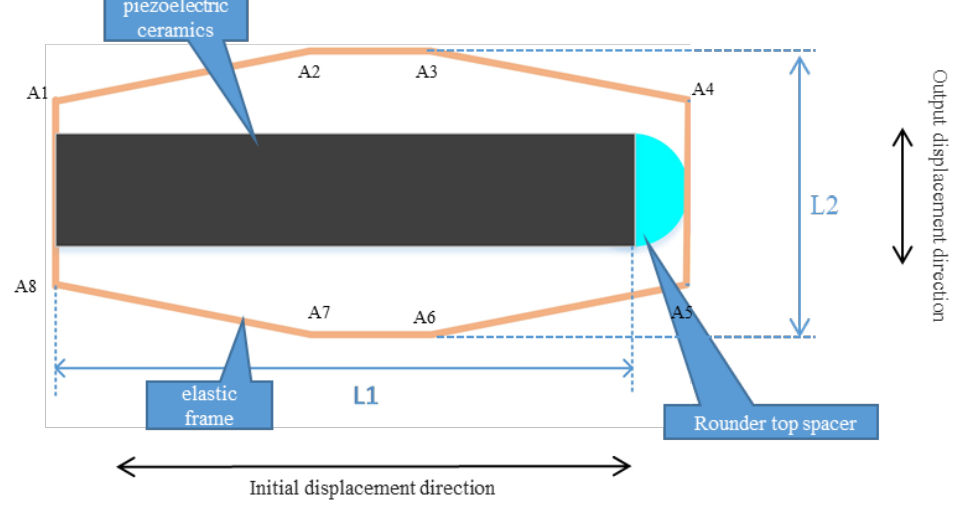
Figure 2. Simplified schematic diagram of the actuator.